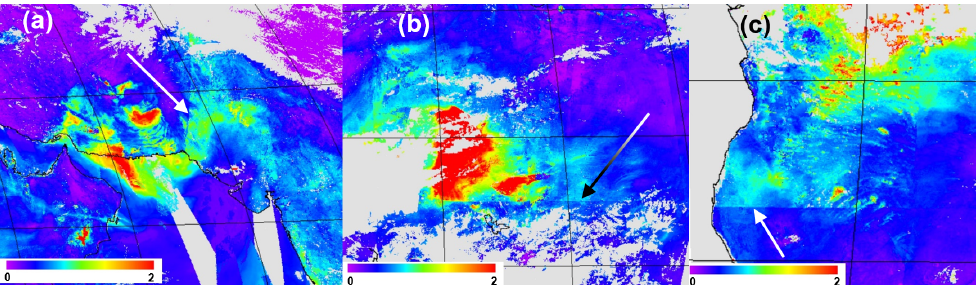
Figure 9. Illustration of MAIAC AOD contrast on the boundary of aerosol models (see Fig. 4) caused mainly by the difference in aerosol absorption between the models: (a) transition 8–2 (day 82, 2010), (b) transition 7–6 (day 113, 2010) and (c) transition 7–2 (day 237,